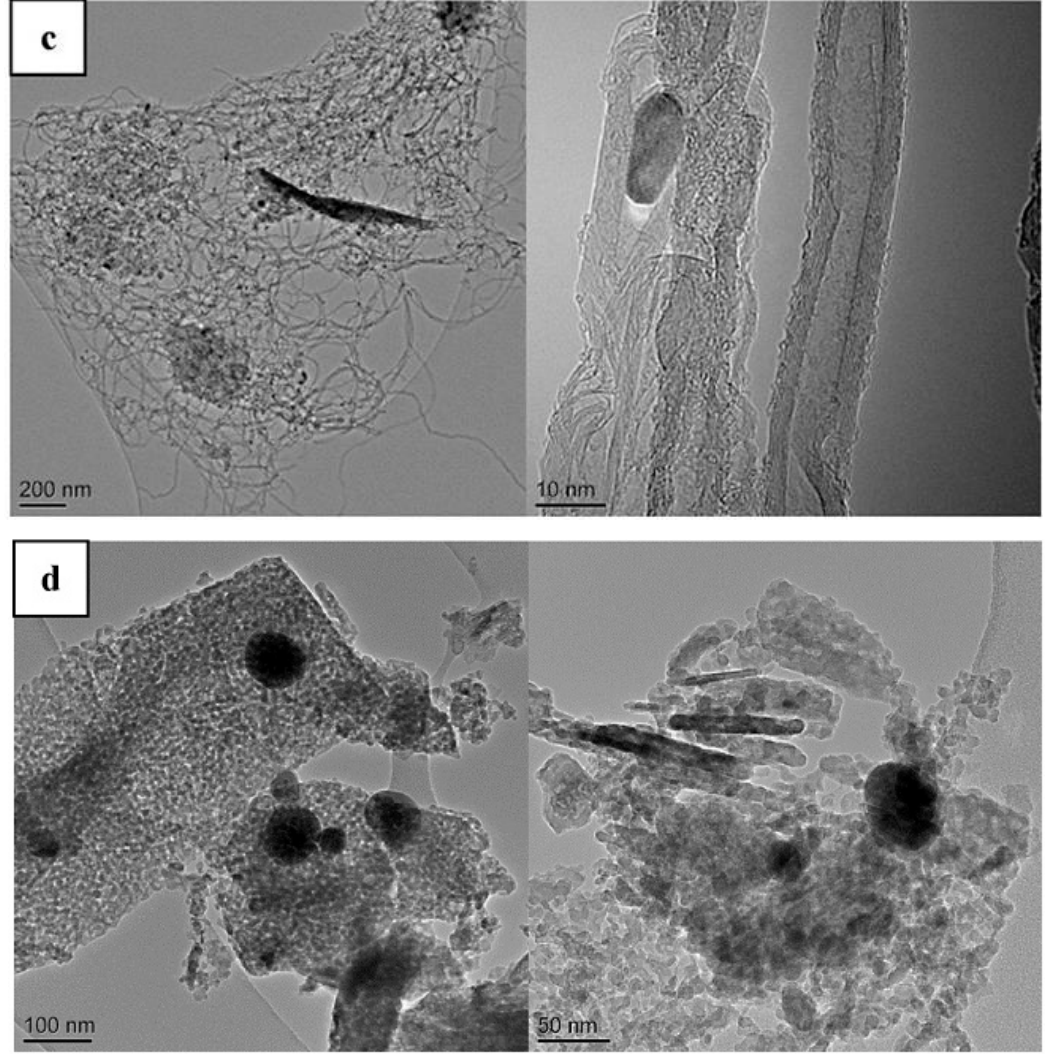
Figure 11. TEM images of the used Al 2 O 3 catalysts doped by different metals: ( a ) Ni; ( b ) Fe; ( c ) Co and ( d ) Cu (reprinted with permission from Ref. [71], copyright 2016 Elsevier).